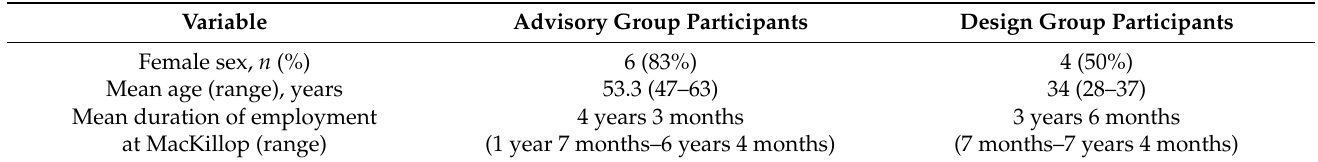
Table 3. Demographic characteristics of the intervention planning